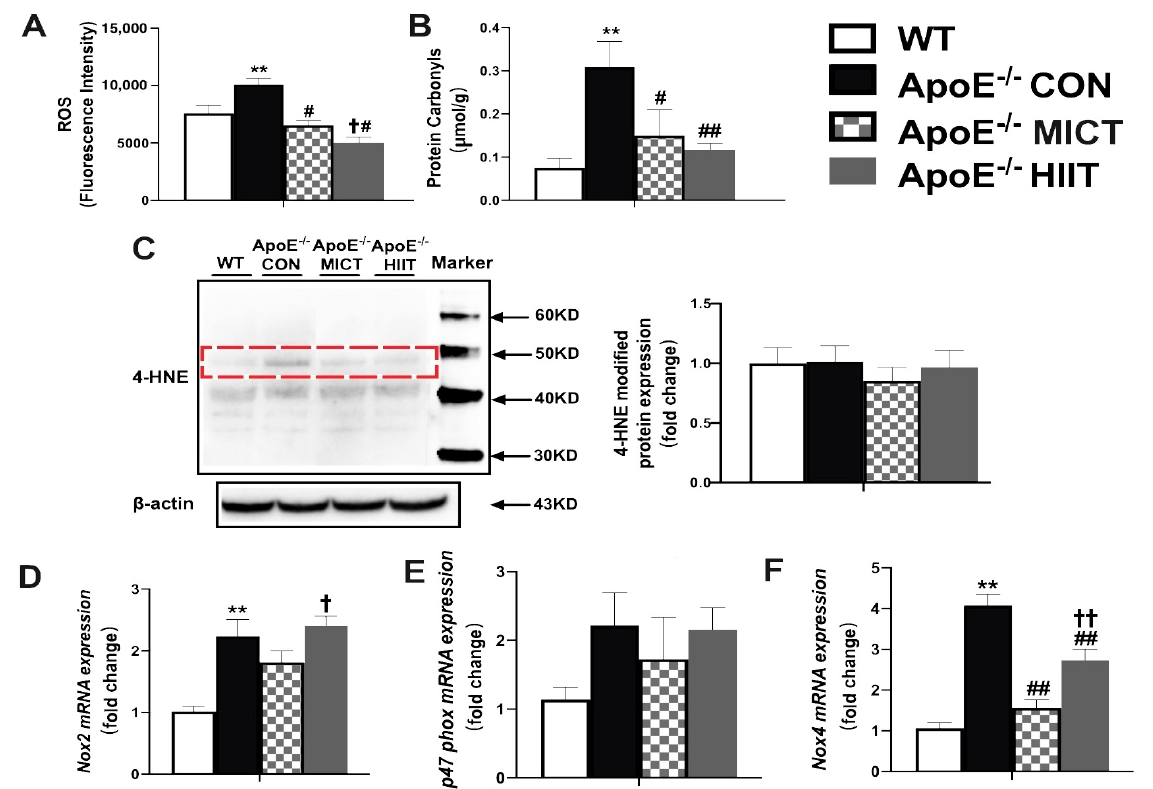
Figure 3. Effects of HIIT and MICT on ROS generation ( A ), protein carbonyl ( B ), 4-HNE-modified proteins ( C ), and the mRNA expression levels of Nox2 , P47phox , and Nox4 ( D – F ) in skeletal muscles of WT and ApoE KO mice with HFD. Values are displayed as the mean ± SEM ( n = 10/group). ** p < 0.01 vs. WT; # p < 0.05 vs. ApoE − / − CON; ## p < 0.01 vs. ApoE − / − CON; † p < 0.05vs. ApoE − / − MICT; †† p < 0.01 vs. ApoE − / − MICT.